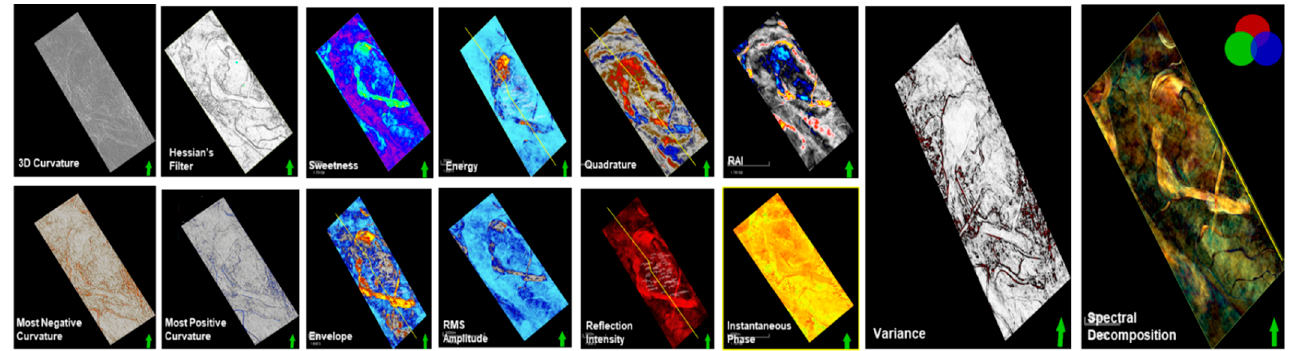
Figure 4. Sixteen types of seismic attributes extracted from A Field. Three different frequency volumes were blended to generate Spectral Decomposition volumes in the I-35 Lower Reservoir.